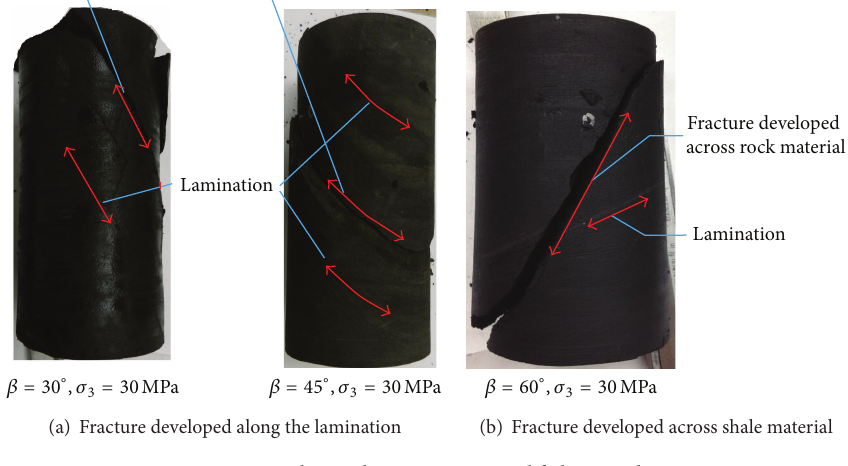
Figure 15: Photos showing two typical failure modes.